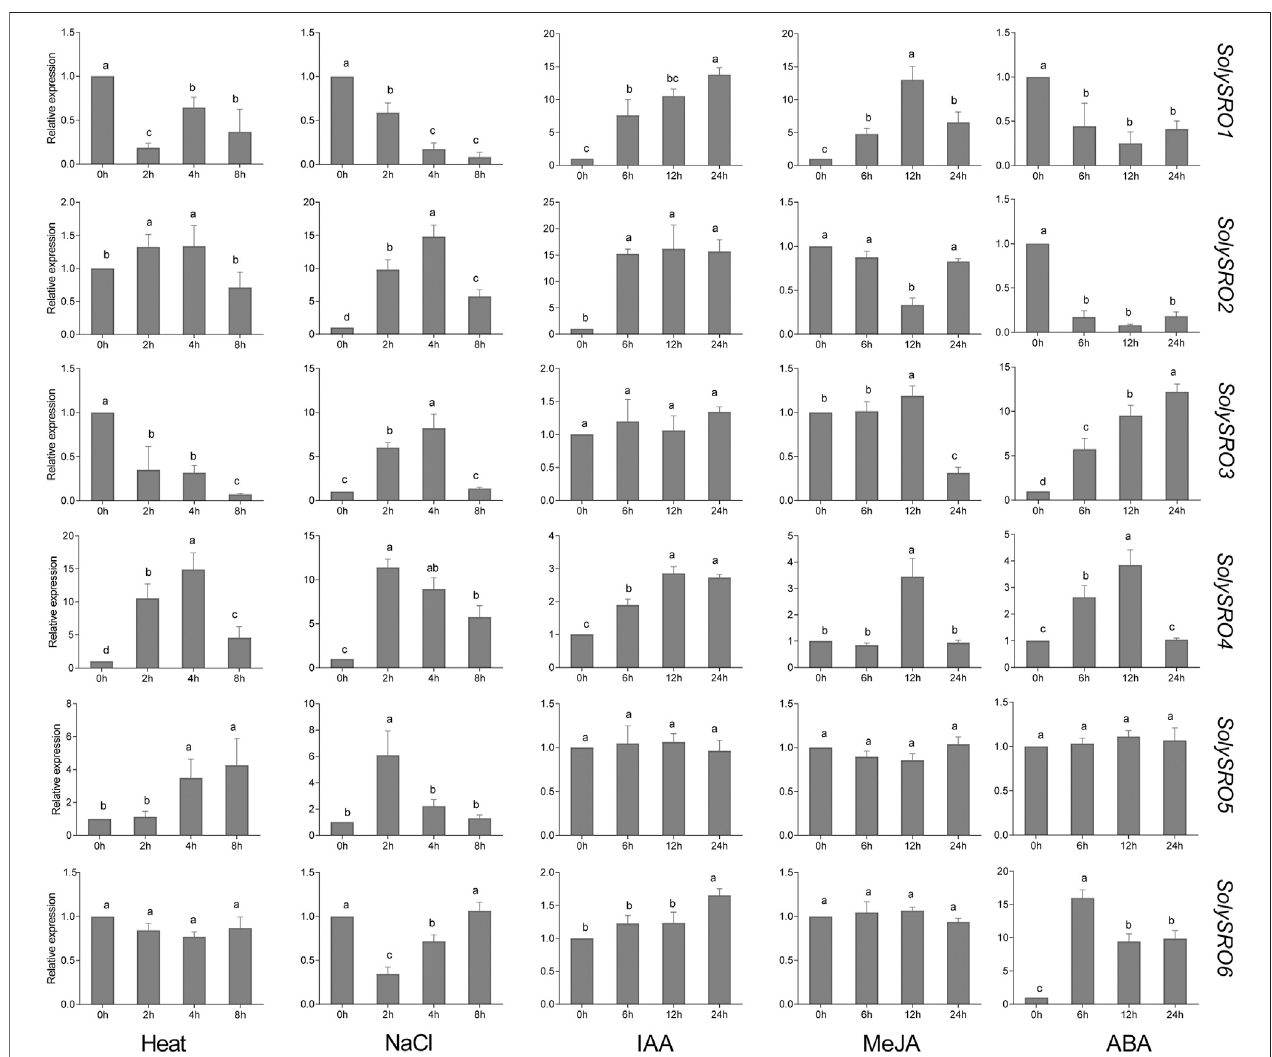
FIGURE 7 | Real-time quantitative PCR validation of SRO genes under abiotic stress and hormone induction, The standard deviations are shown with error bars.